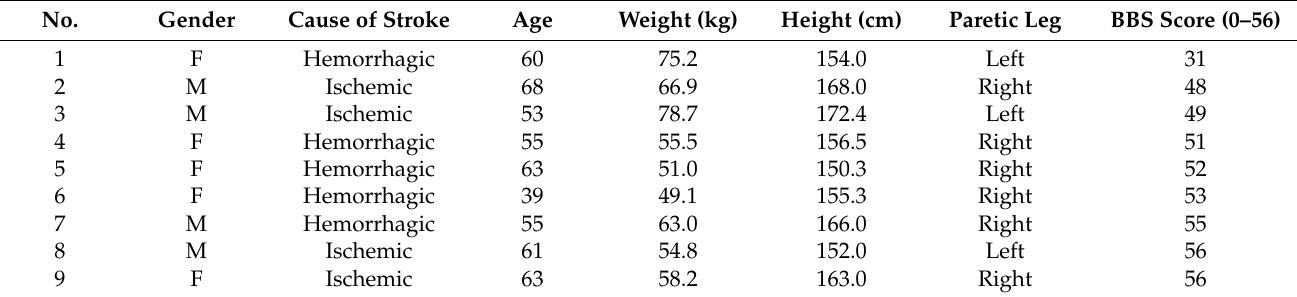
Table 1. Participants’ characteristics (n =